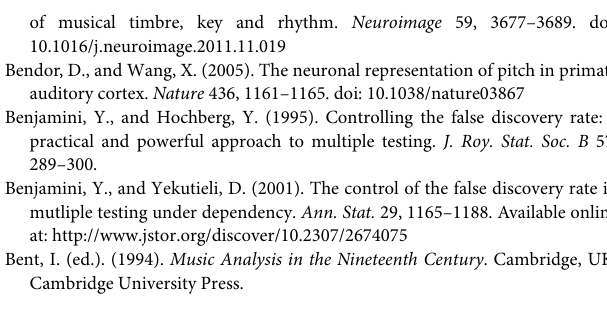
each of the music stimuli, scrambled at each of several timescales. Error bars indicate estimated standard error. Abbreviations: TRA, transverse view of brain; R, right hemisphere; L, left